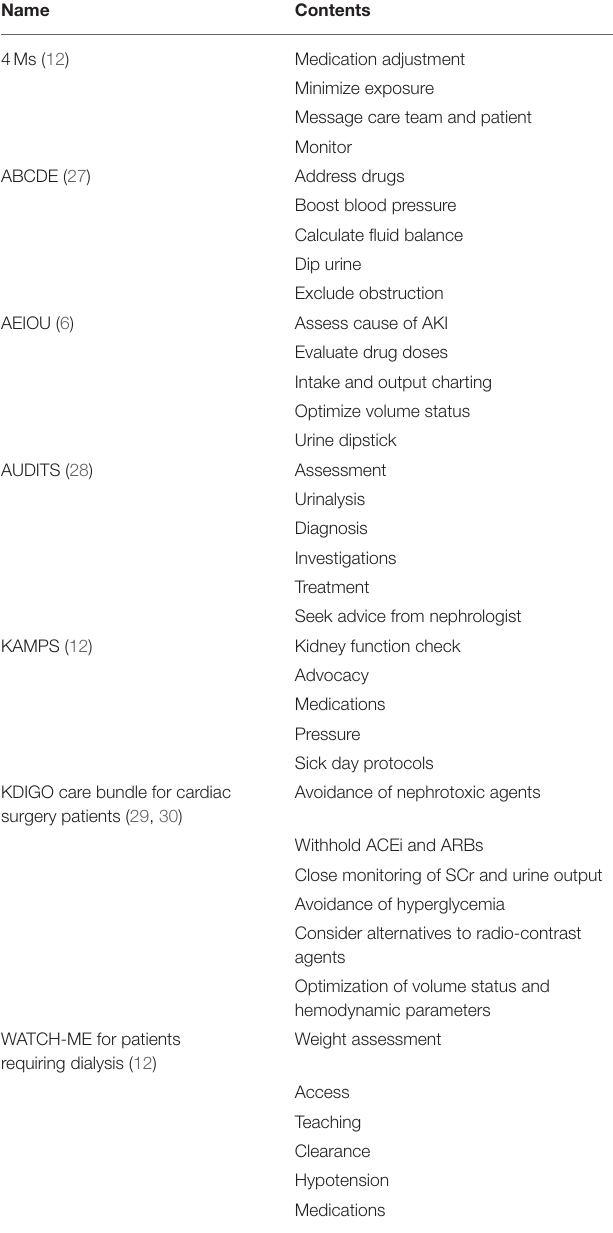
TABLE 1 | Care bundles for acute kidney